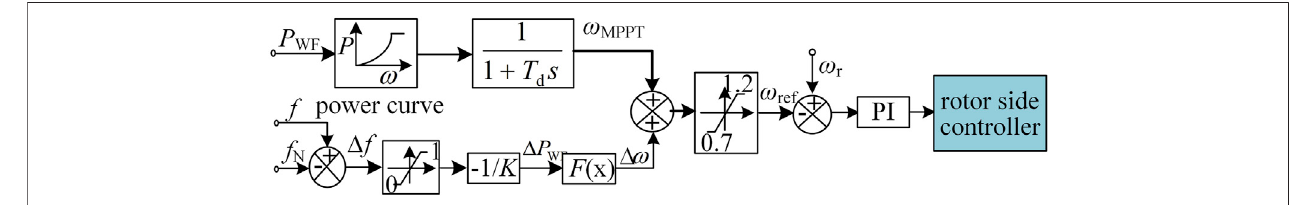
FIGURE 2 | Overspeed load reduction control strategy of the